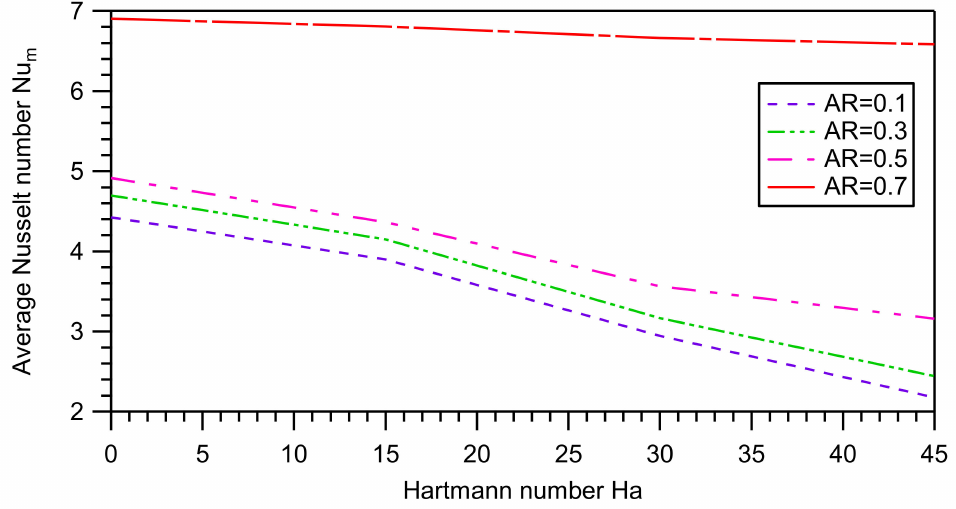
Figure 16. The average Nusselt number Nu m according to the Hartmann number for di ff erent aspect ratios (AR = 0.1, 0.3, 0.5 and 0.7) with Ra = 10 5 , Da = 10 − 2 , ϕ = 0.04, Fr = 0.75, ω = 0 and q ∗ =